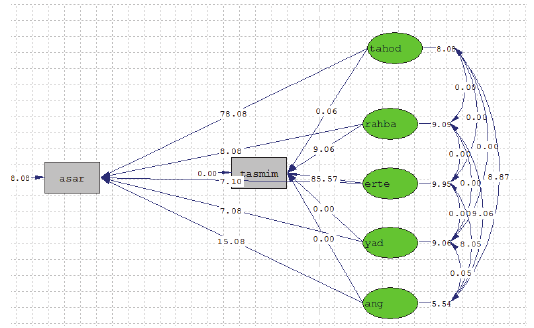
Fig. 2. The results of the implementation of LISREL program